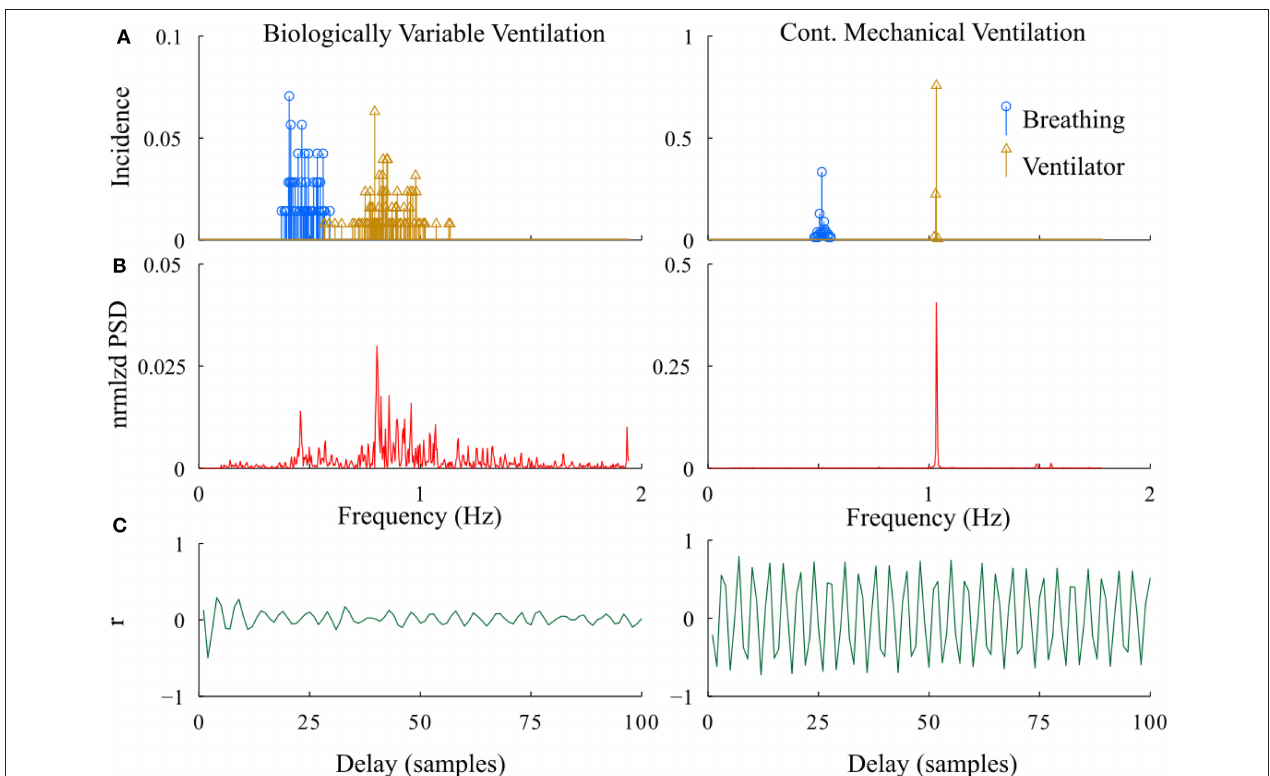
FIGURE 6 | Representative examples of differences in the periodicity of heart rate during BVV and CMV. (A) Histograms of instantaneous fR (breathing) and VR (ventilator). (B) Power spectral density of the RR interval. (C) Autocorrelation plots of RR interval. As expected, the distribution of VR was much wider during BVV than CMV and this was reflected not only in the distribution of spontaneous fR but also in the PSD of the RR intervals, which were distinctly different. These differences were reflected in the autocorrelation plots which illustrated beat-to-beat variability during BVV but periodicity during